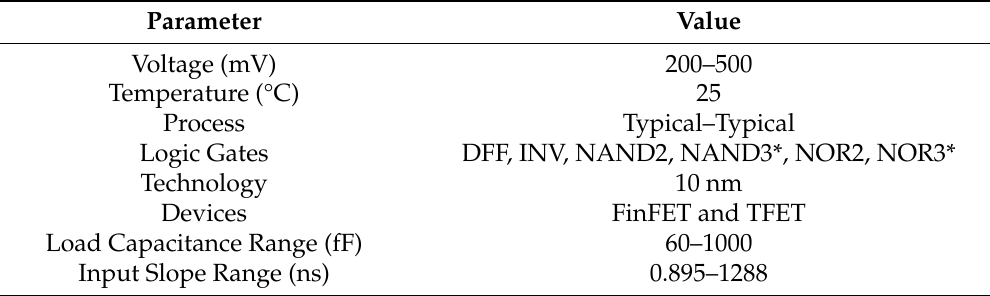
Table 3. Standard cell library